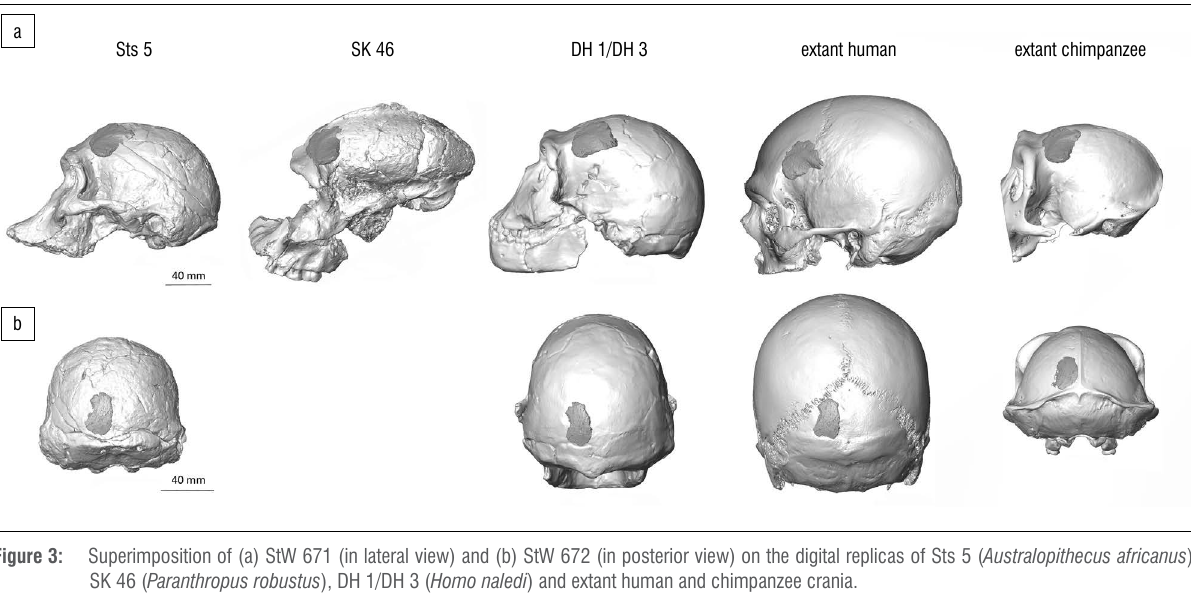
Figure 4. From Beaudet et al. 18 , we specifically selected measurements 1–20 and 40–50, respectively representing the frontal and occipital bones (Figure 2c). Additionally, we compiled comparative measurements